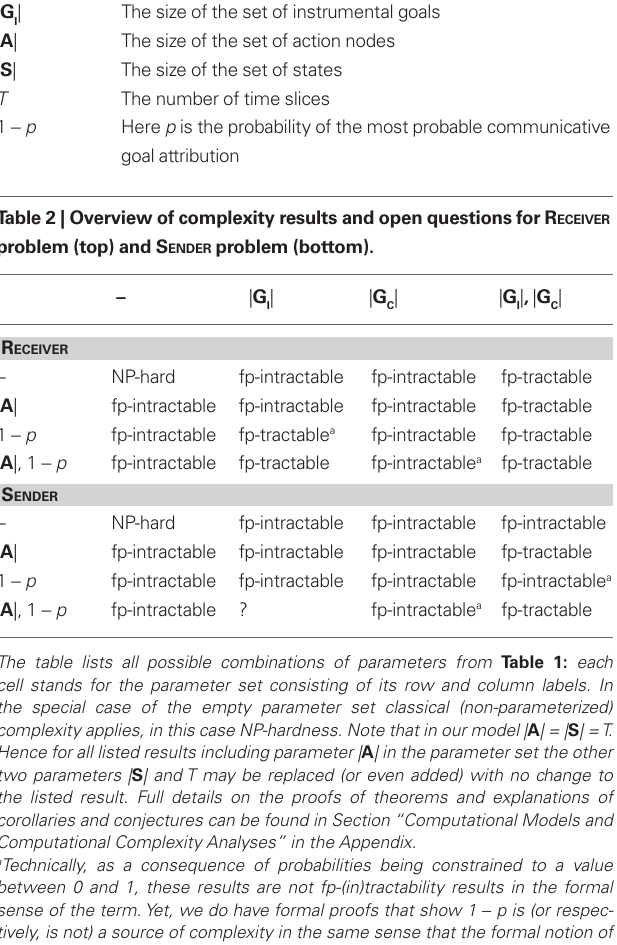
Table 1 | Overview of parameters considered in our tractability analyses.